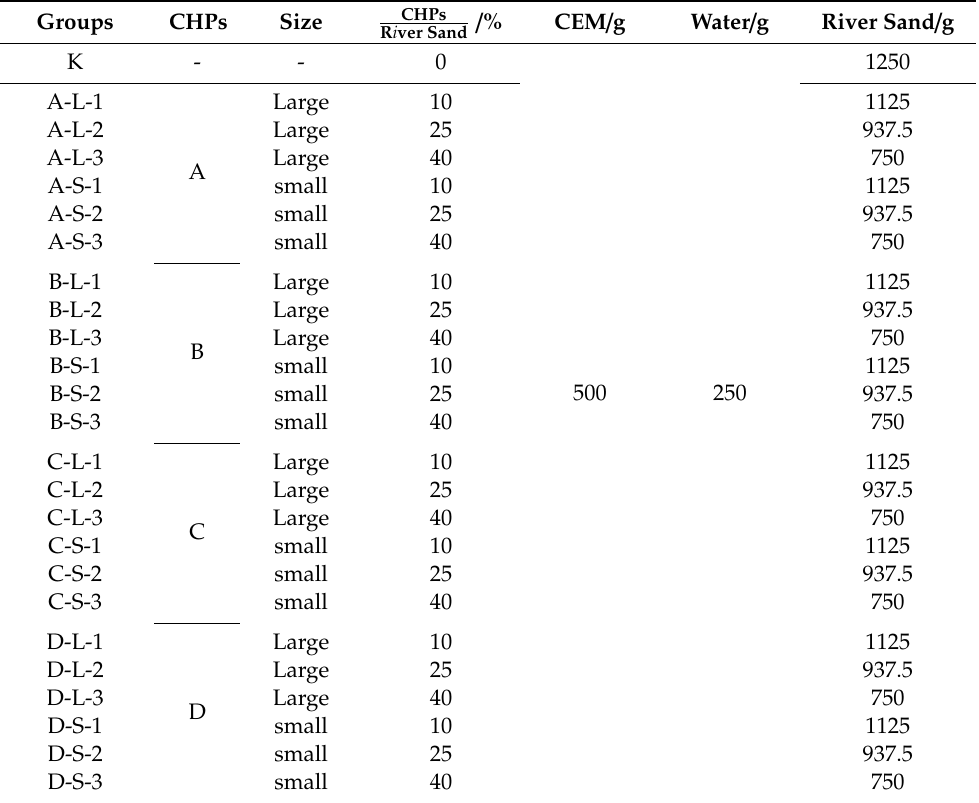
Table 3. Mixing ratio of cement